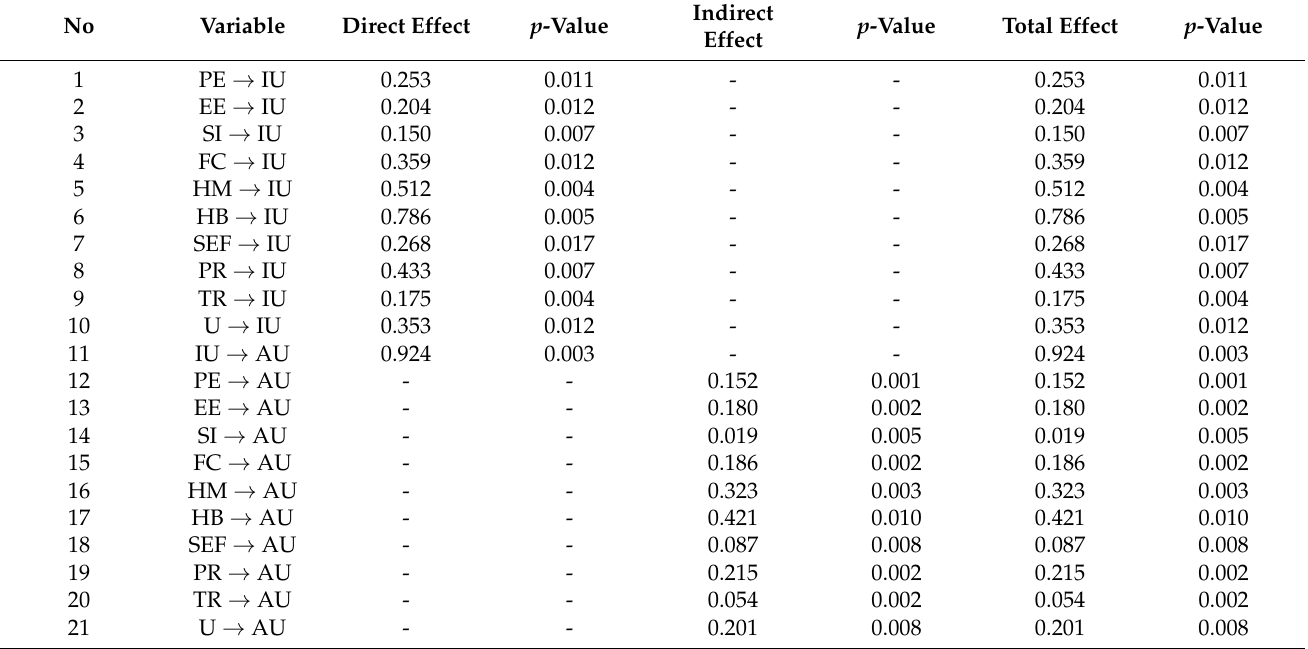
Table 6. Direct, indirect, and total